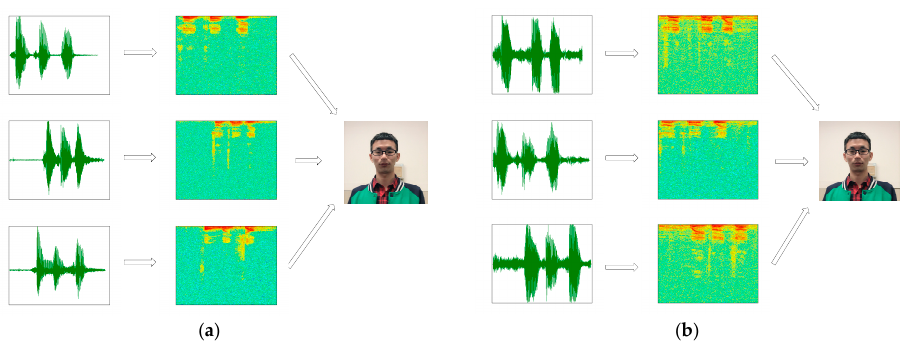
Figure 14. Speech signal—speech spectrogram conversion diagram. ( a ) The speech collected in the laboratory and the corresponding spectrogram, and ( b ) the speech collected in the supermarket and the corresponding spectrogram.